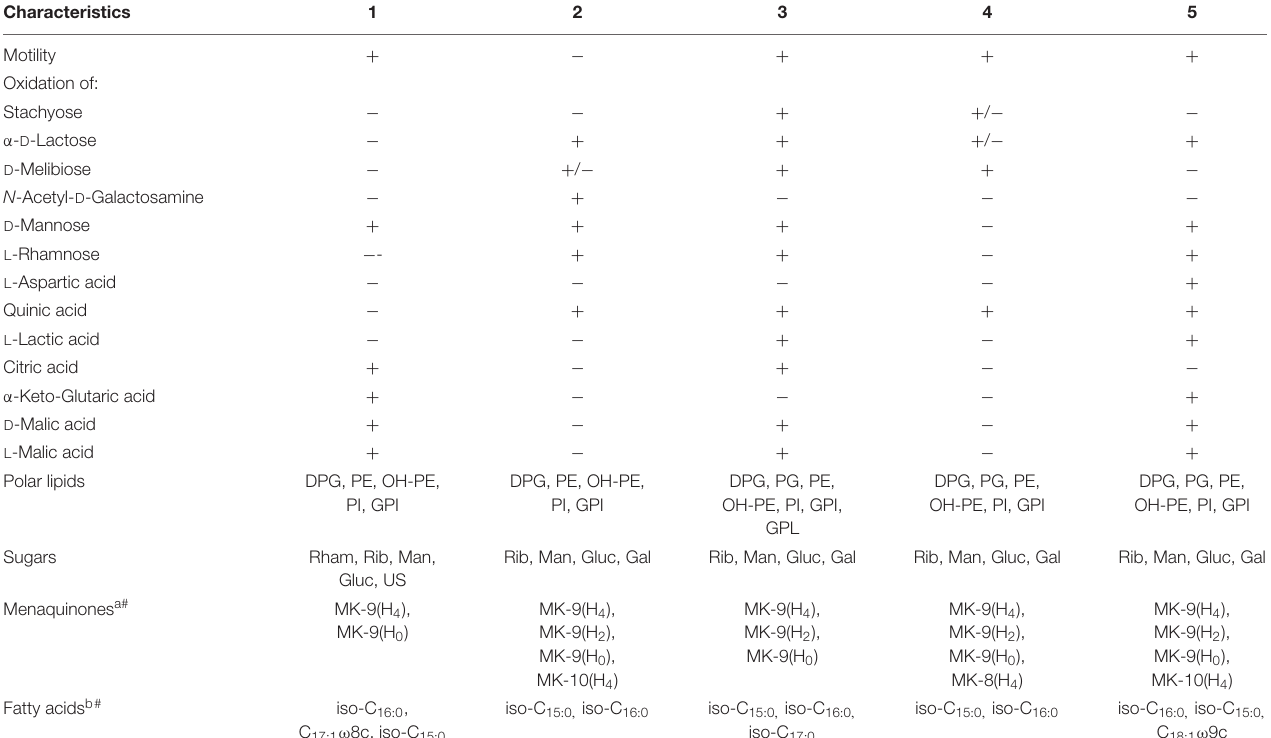
TABLE 1 | Phenotypic characteristics of strain YIM M13156 T in comparison to those of the type strains of the most closely related Geodermatophilus species.